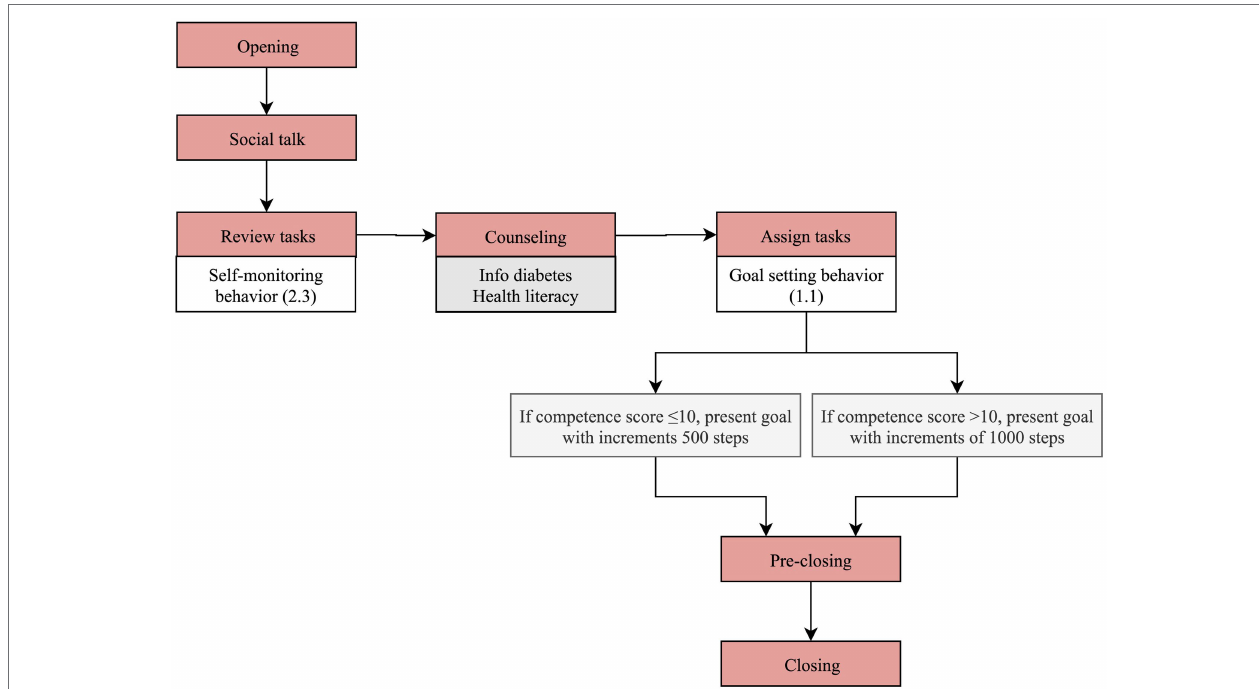
FIGURE 3 | Dialogue flow in day 1 of physical activity component of the follow-up stage.